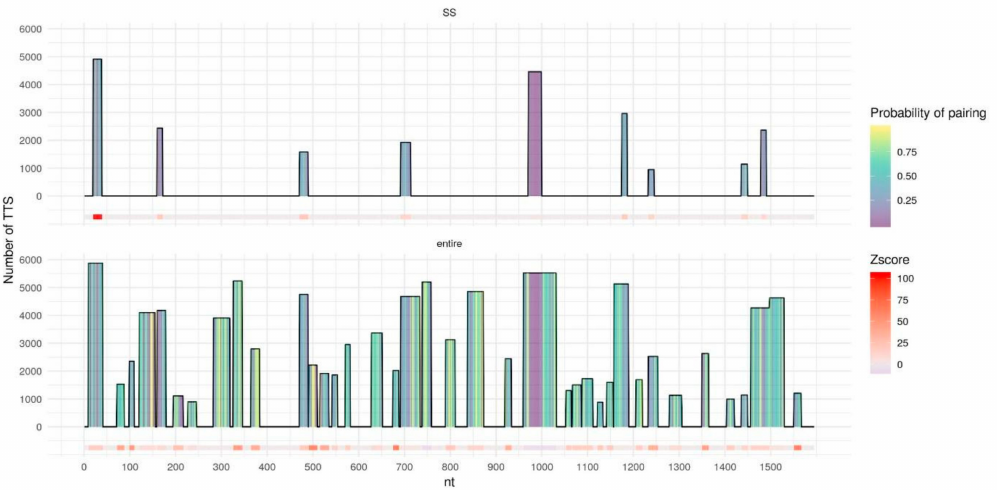
Figure 5. DNA binding domains (DBDs) of the entire MEG3 (bottom) and of single-stranded fragments of MEG3 (top), predicted by TDF with MEG3 best parameters (l10e20g40). The horizontal axis represents MEG3 in length, columns represent DBDs with height corresponding to the number of DNA peaks (Triplex target sites, TTS) with predicted triplexes for the particular DBD. DBDs columns are filled with color by the probability of pairing for each nucleotide predicted by RNAplfold. DBDs in the MEG3 sequence are colored by z-score for a particular DBD calculated by TDF based on random samplings from the human genome; z-score = 0 corresponds to no DBDs